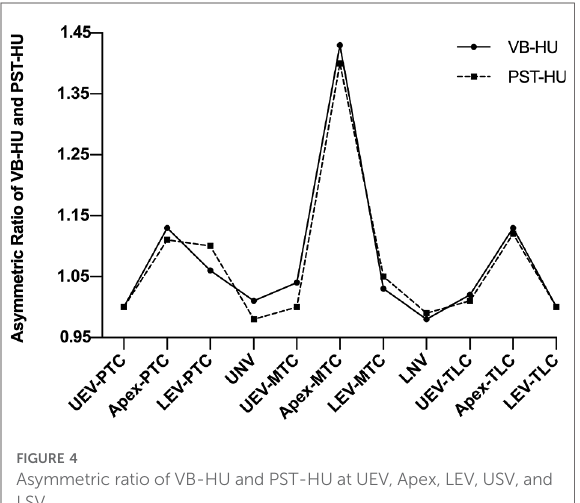
FIGURE 4 Asymmetric ratio of VB-HU and PST-HU at UEV, Apex, LEV, USV, and LSV.